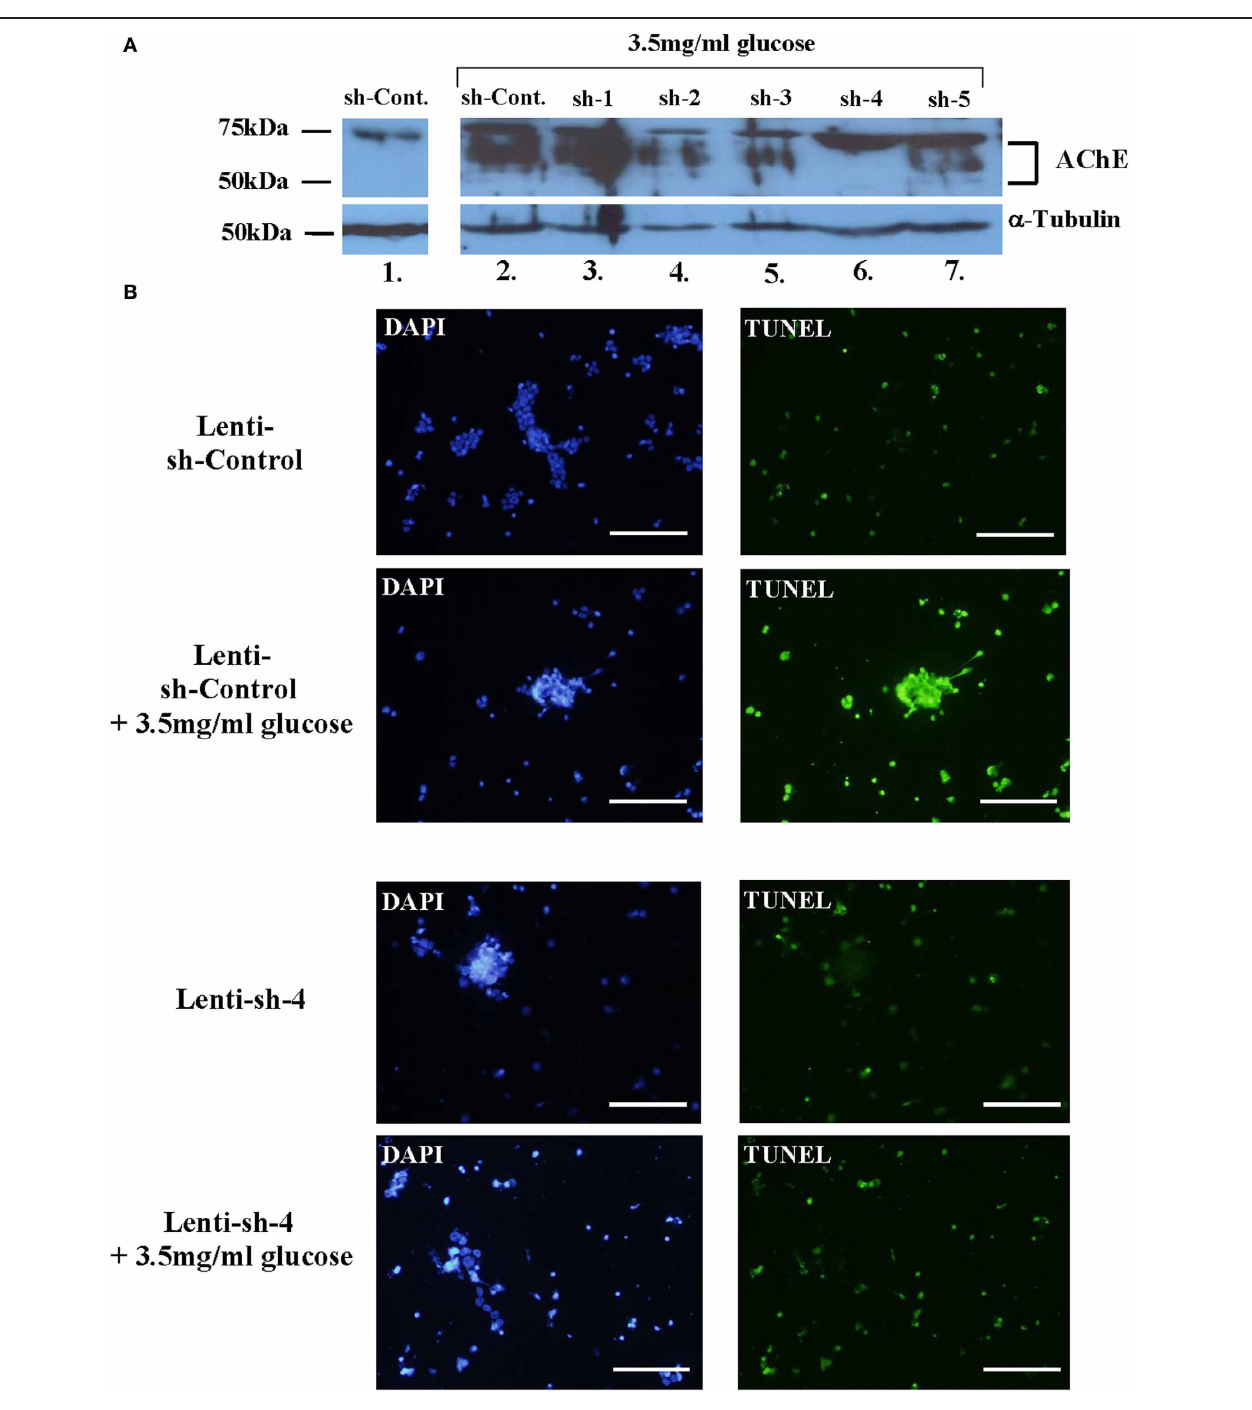
with apoptosis, via a PKC-delta isoform-dependent pathway, while higher glucose or mannitol concentrations activated p38 kinase by hyperosmolarity via a PKC-independent pathway (Igarashi et al.,